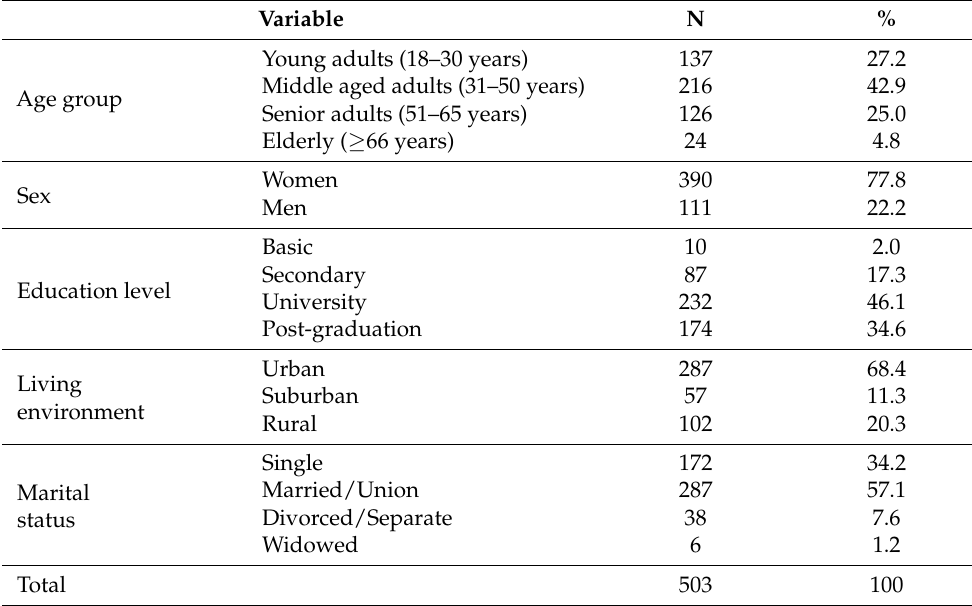
Table 2. Sociodemographic characterization of the sample at study.